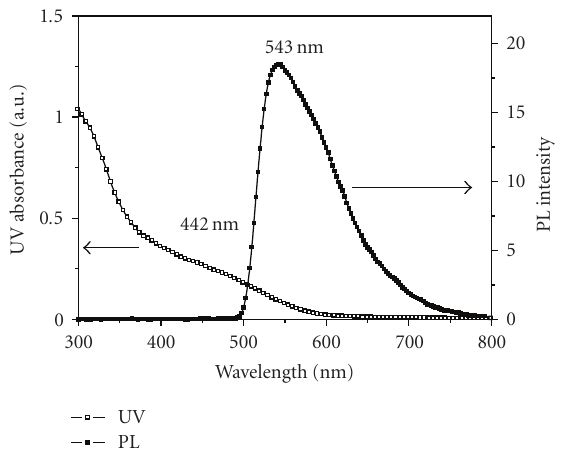
Figure 3: Optical absorption and photoluminescence spectra of poly(DEDPM) solution.